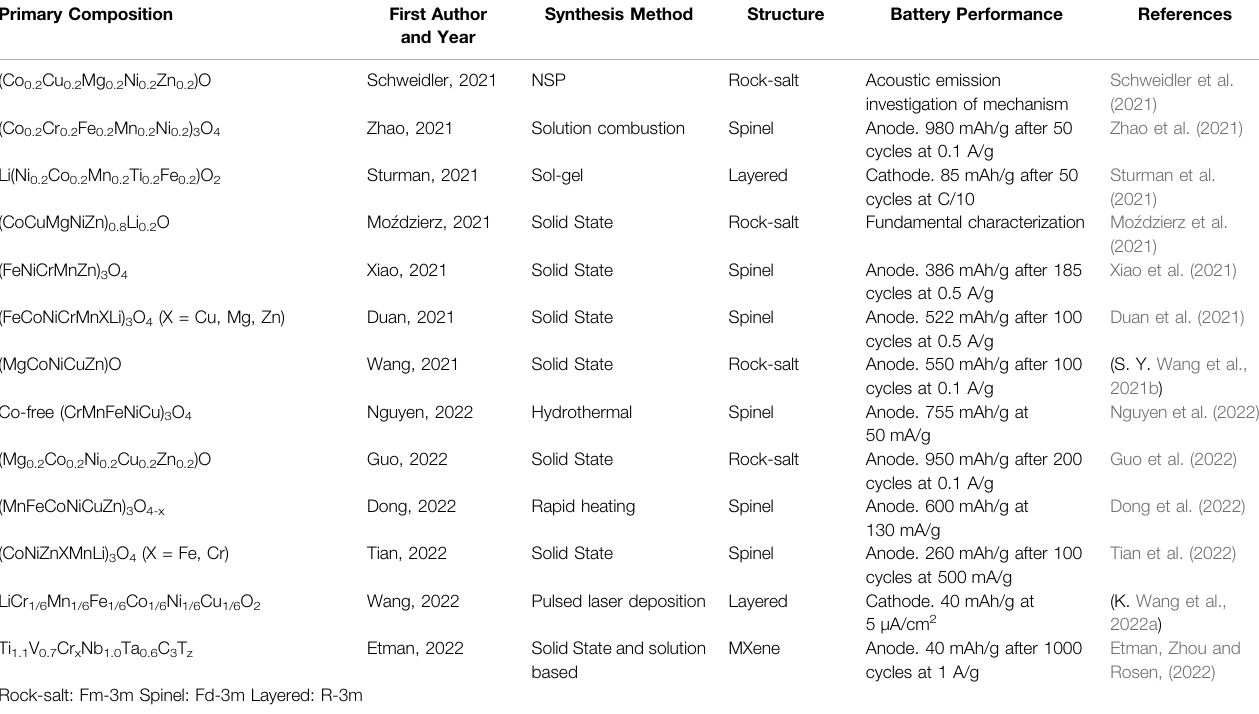
Rock-salt: Fm-3m Spinel: Fd-3m Layered: